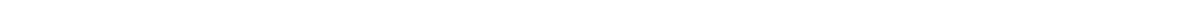
Figure 3 | Reconstituting PD-L1 expression in tumour cells influences tumour outgrowth. PD-L1-deficient MC38 tumour cells were reconstituted with doxycycline inducible RFP (red circles), or PD-L1 (blue circle) using a lentiviral construct encoding constitutive GFP. PD-L1 reconstitution resulted in restored tumour outgrowth ( a ), while PD-L1-deficient tumours with doxycycline inducible RFP regressed. End-point analysis at day 24 showed that mixed cell (red/blue circles) inoculation led to tumours slightly smaller compared to tumours generated from PD-L1-enabled tumour cells only ( b ). While RFP þ GFP þ tumour cells were detectable by flow cytometry at time of inoculation, this population was lost at endpoint, and solely PD-L1 þ GFP þ cells remained from the mixed inoculation ( c ). PD-L1 on target cells can inhibit antigen specific cytolytic T-cell activity in a dose dependent manner in vitro ( d ). Following complete regression of PD-L1-deficient CT-26 tumours, mice re-challenged with PD-L1-deficient (red) or wildtype (blue) tumours showed complete tumour regression ( e ), despite outgrowth of syngeneic EMT6 (black) tumours on the opposing flank ( f ). Following complete regression of MC38 PD-L1-deficient tumours, mice re-challenged with MC38 tumour cells over-expressing doxycycline induced PD-L1 (light blue) showed near complete tumor regression ( g ), despite over-expressed PD-L1 enabling slightly faster tumour progression in naive mice ( h ). Characterization of tumor subsets by flow cytometry in tumours was performed at day 19 post-inoculation. Data is representative of at least two individual study repeats, with 3 to 10 mice/group. Cytolytic in vitro assays were repeated four times with representative data shown. Dox, doxycycline; NA, naive; OVA, ovalbumin. Statistical significance was determined by Student’s t -test (* P o 0.05; ** P o 0.01; *** P o 0.001). Error bars depict s.d. from the mean. Mouse cartoon modified from ref.